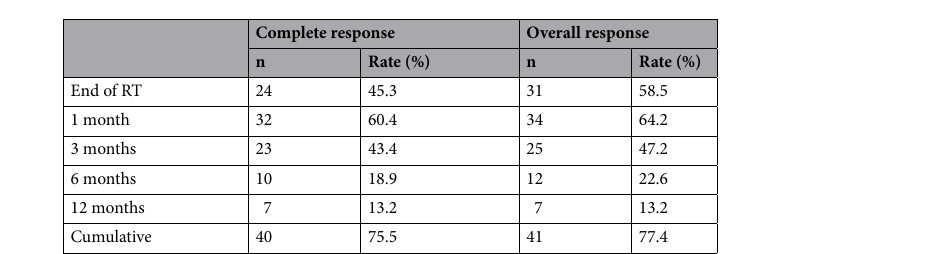
Table 4. Gross hematuria response rate at the end of radiation therapy and 1, 3, 6, and 12 months after radiation therapy in 53 patients with advanced cancer. Complete response (CR) was defined as the absence of gross hematuria. Partial response (PR) was defined as an improvement and a decrease in gross hematuria frequency but not complete disappearance. Overall response (OR) was defined as CR combined with PR. Abbreviations: RT radiation